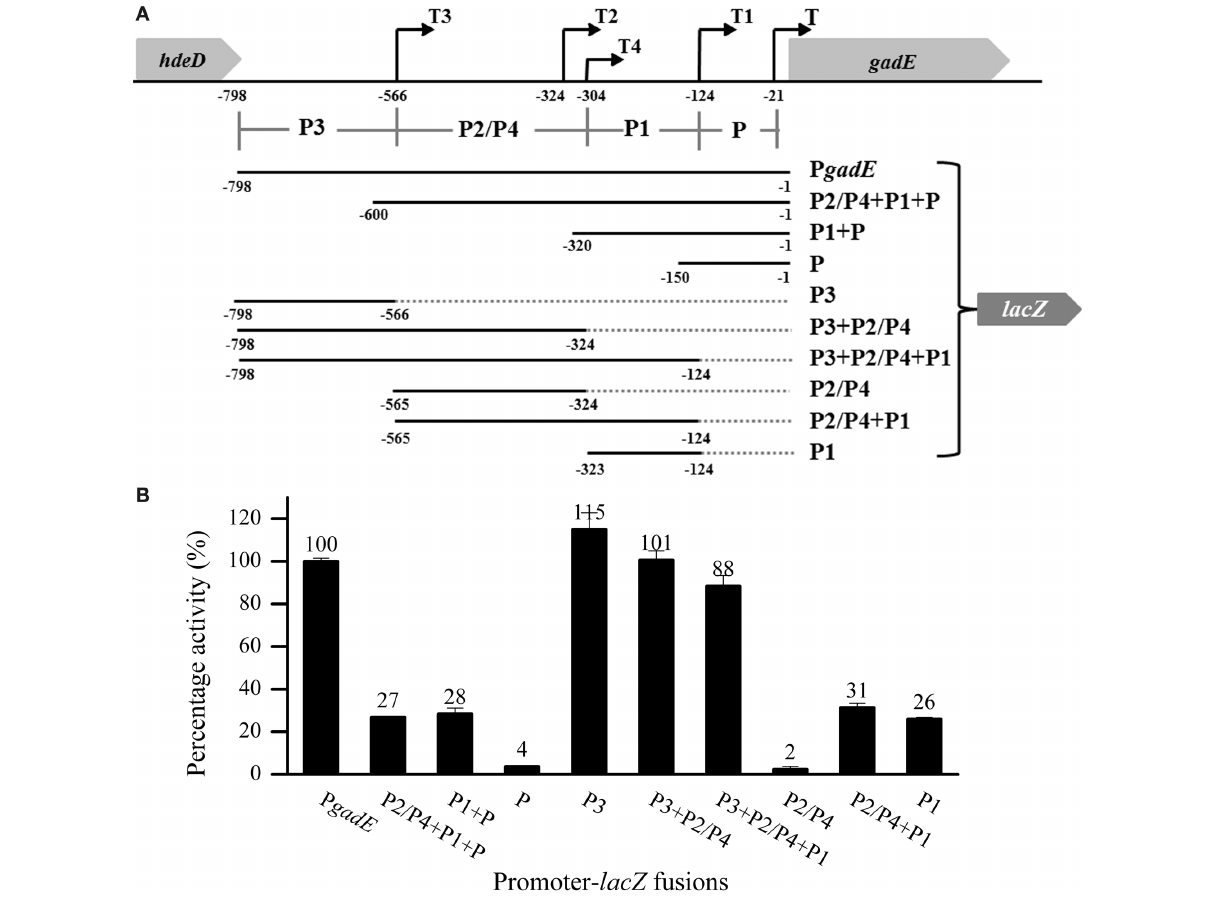
designated as its individual promoters, labeled as P3, P2/P4, P1, and P, respectively. (B) Promoter activity of all P gadE truncations determined by β -galactosidase activity of corresponding lacZ fusions. Cells were grown anaerobically to exponential phase (A 600 = 0 . 3) in minimal M9 glucose medium. Results are presented as percentages relative to that of full length gadE promoter activity (100%), and error bars represent the standard errors of triplicate experiments ( n =